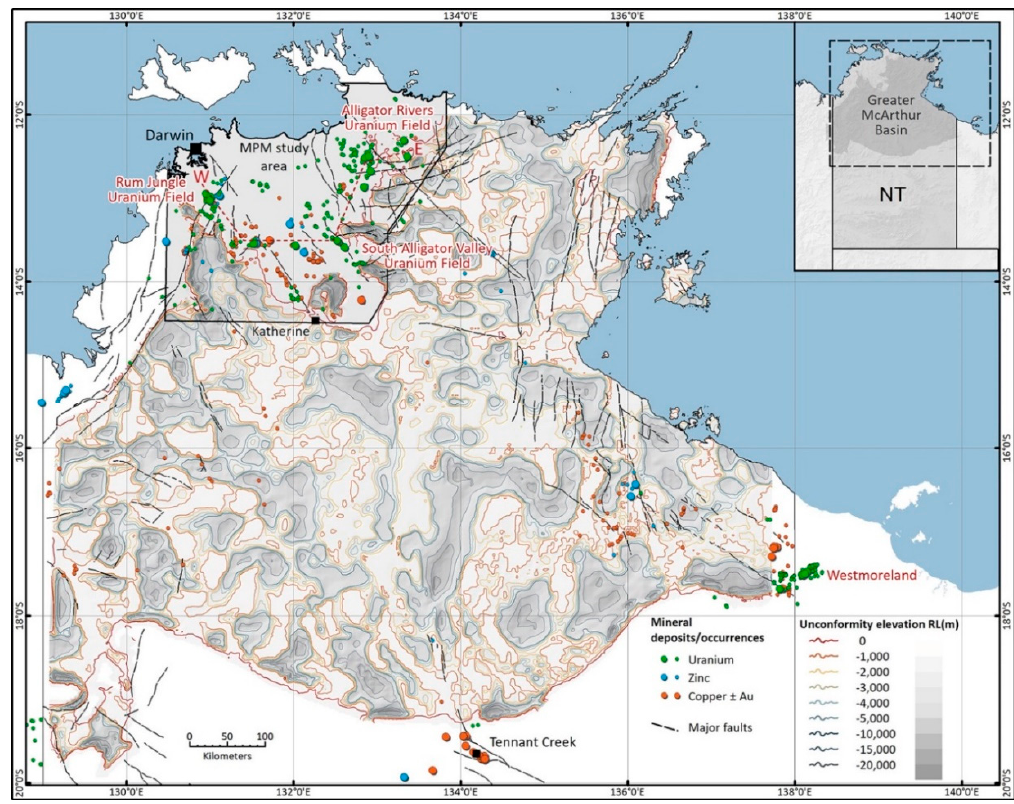
Figure 2. Unconformity elevation contours—Greater McArthur Basin. Contours indicate the elevation of the unconformity below the ‘Redbank package’, which includes the Paleoproterozoic Kombolgie Subgroup near its base. Unconformity elevation data sourced from the Northern Territory Geological Survey (2015). The NW McArthur Basin mineral potential modelling (MPM) study area (black outline) includes the Alligator Rivers, South Alligator Valley and Rum Jungle uranium fields. The red dashed line (W-E) marks the approximate trace of the cross section shown in Figure 4a.